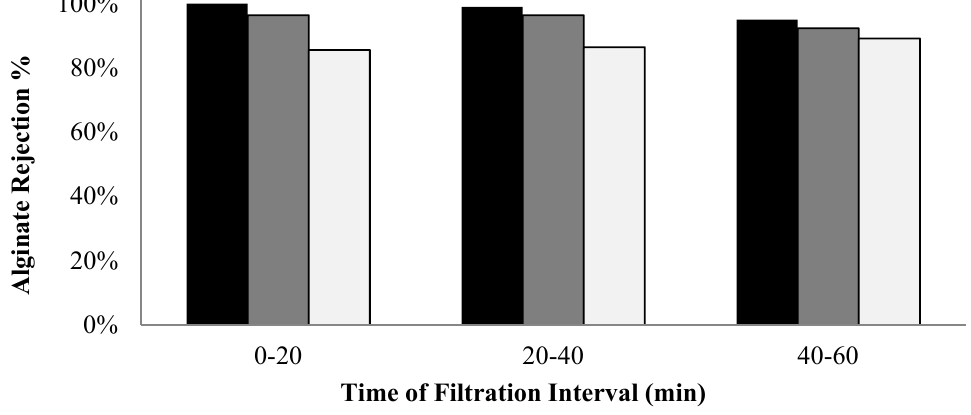
Figure 11. Alginate rejection for filtration of solutions with different ratios of BSA to